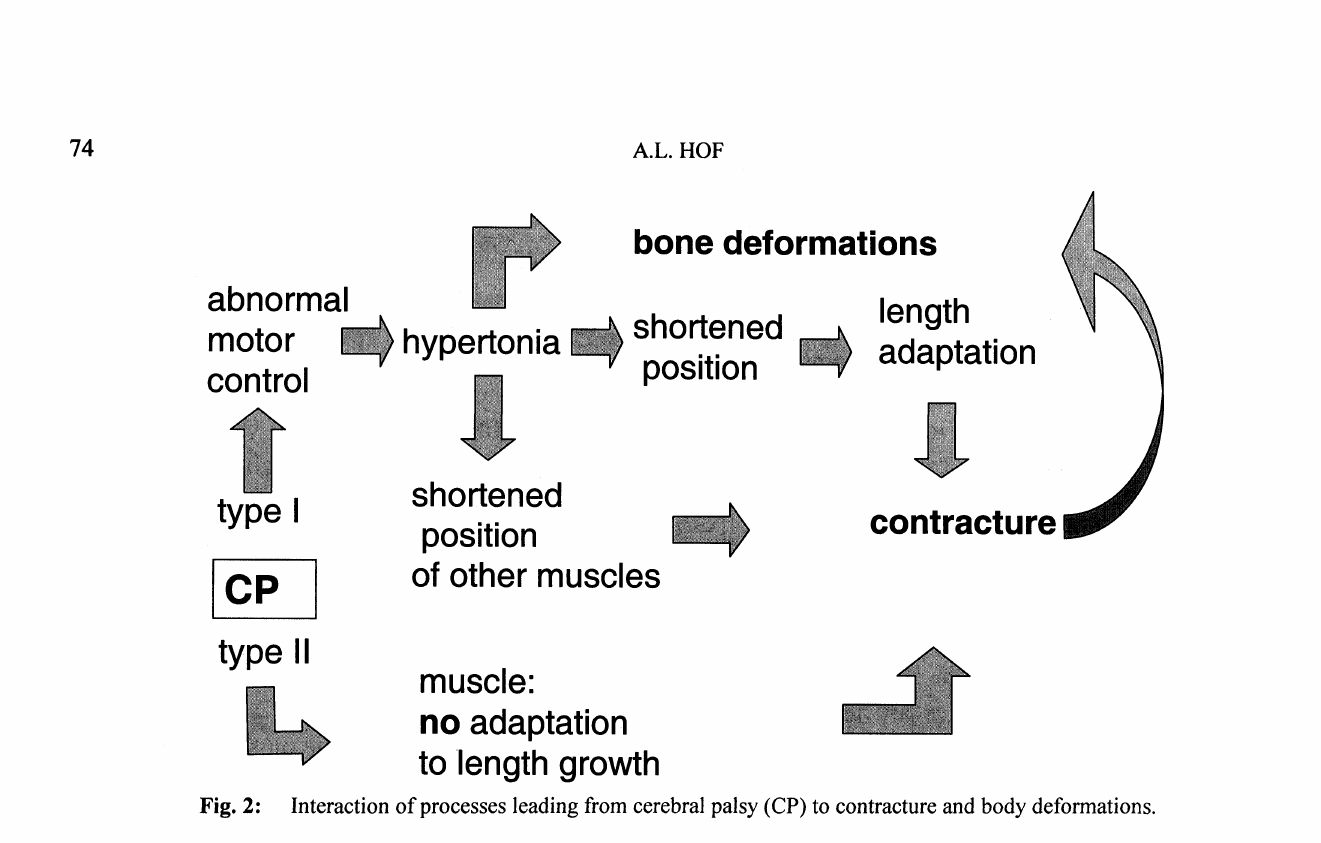
Fig. 2: Interaction of processes leading from cerebral palsy (CP) to contracture and body deformations.